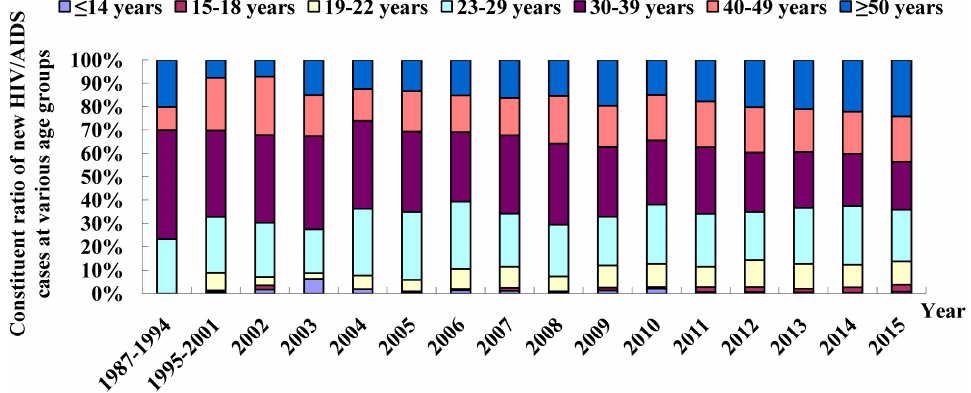
Figure 3. Age-specific distribution of new HIV/AIDS patients reported in Fujian Province from 1987 to 2015.